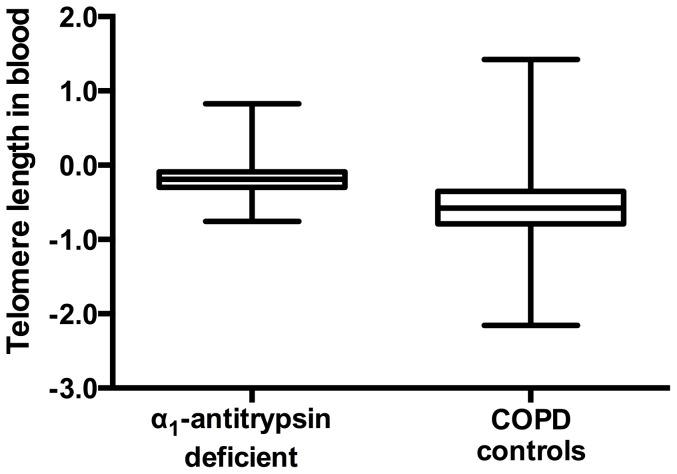
Log10 of telomere length in α1-antitrypsin deficient COPD patients vs. log10 of telomere length in COPD controls.